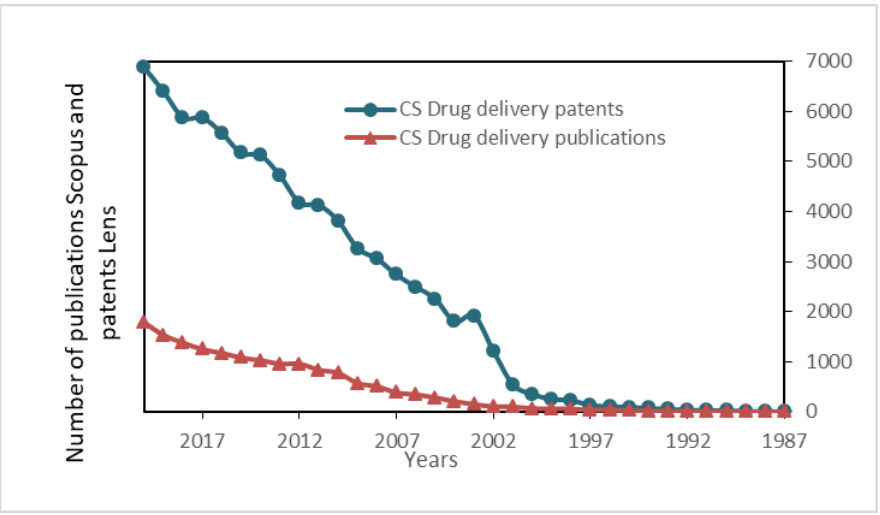
Figure 10. Publications about chitosan drug delivery in Scopus and patents in Lens (1987 – 2020).